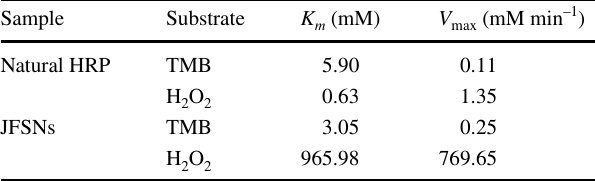
Table 1 POD-like catalytic activities of natural HRP and JFSNs